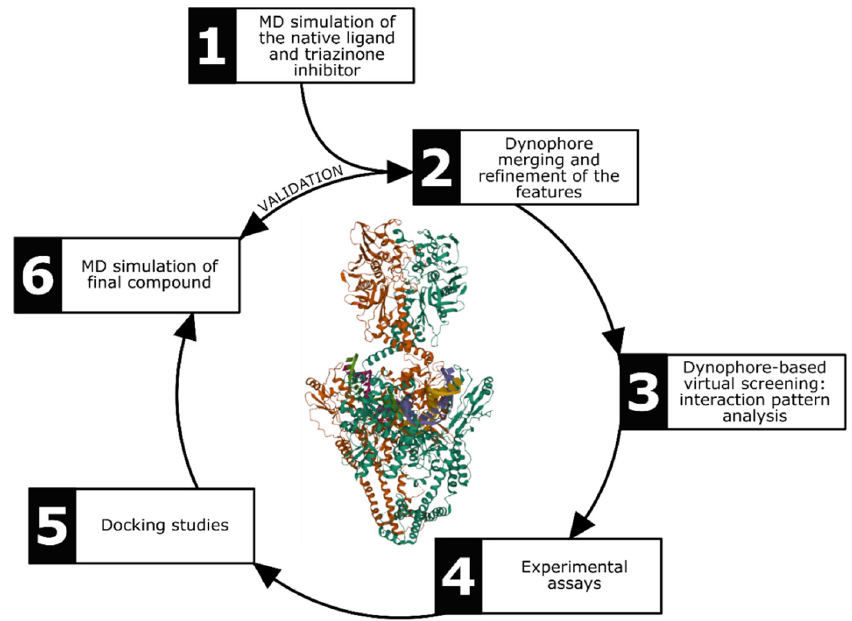
Figure 1. Outline of the research workflow based on dynophore models using human topo II α as a model target.